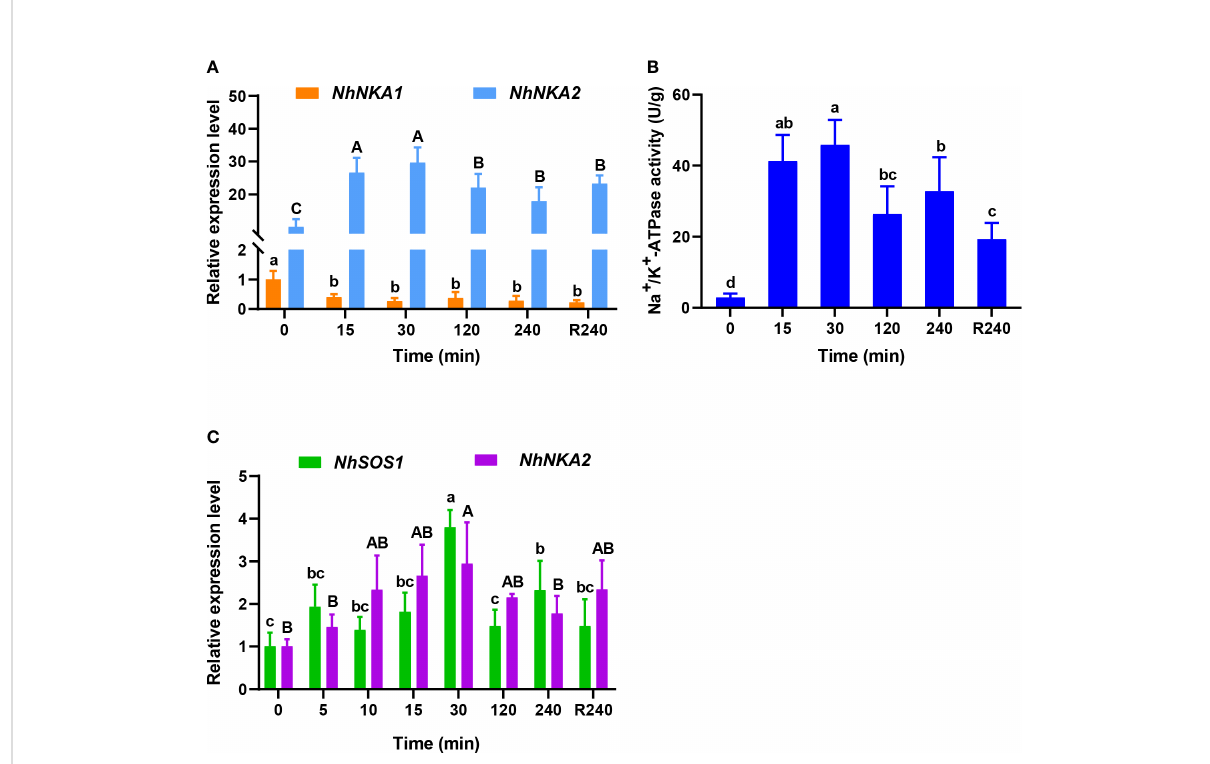
FIGURE 1 Transcript levels of Na + /K + -ATPase (NKA), Na + /H + antiporter (SOS1) and enzyme activity of NhNKA in N. haitanensis at different times under hypersaline stress. (A) Transcript levels of NhNKA1 and NhNKA2 under 100 ‰ hypersaline stress. (B) Enzyme activity of NhNKA under 100 ‰ hypersaline stress. (C) Transcript levels of NhSOS1 and NhNKA2 in the very early phase of 100 ‰ hypersaline stress. R240: 240 min recovery from salt stress in normal seawater (30 ‰ ). Values shown are mean ± standard error of the mean ( n = 3). Different letters indicate signi fi cant differences ( P <